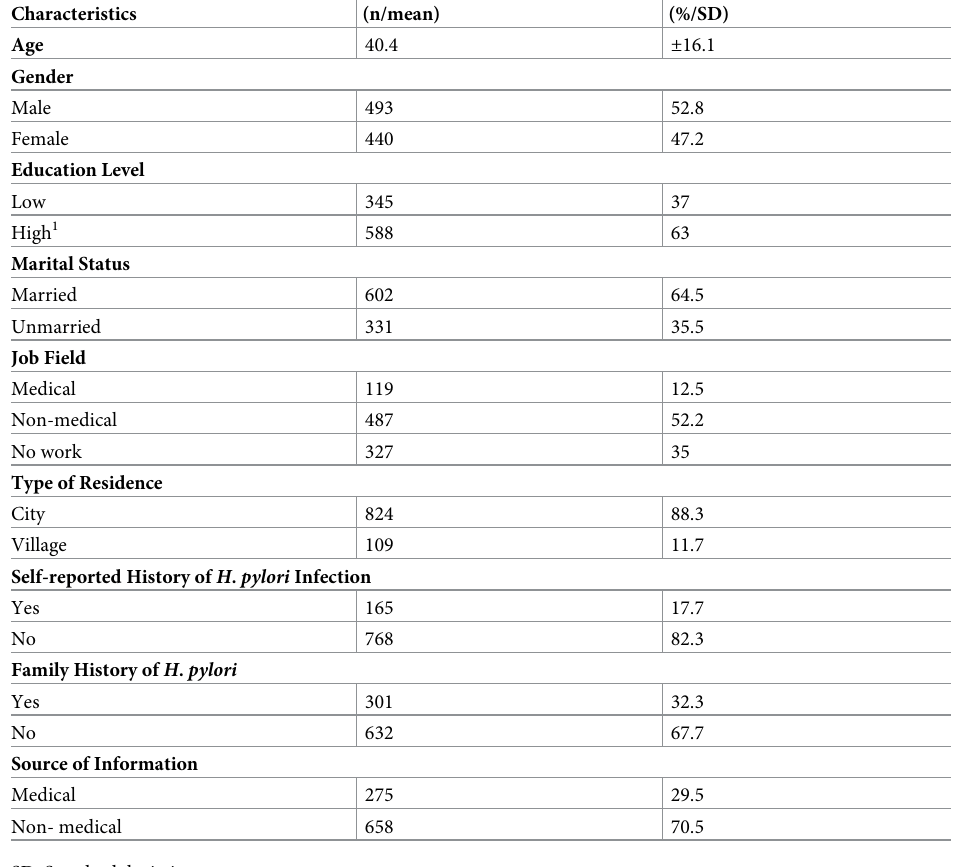
Table 1. Sociodemographic characteristics of H . pylori questionnaire participants (n = 933).